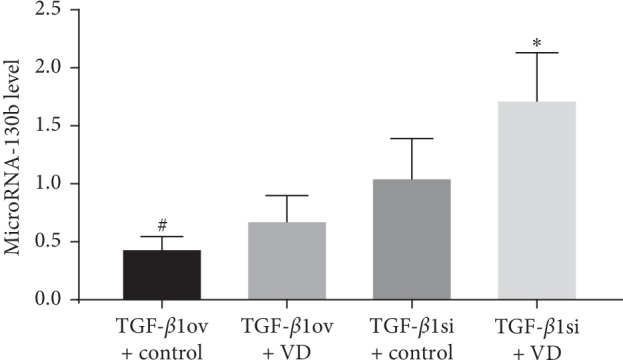
MiR-130b expression levels in DN rats. TGF-β1ov + control, TGF-β1 overexpression + oil; TGF-β1 ov + VD, TGF-β1 overexpression + 1,25(OH)2D3; TGF-β1si + control, TGF-β1 siRNA + oil; TGF-β1si + VD, TGF-β1 siRNA + 1,25(OH)2D3. ∗p < 0.05 vs TGF-β1si + control; #p < 0.05 vs TGF-β1ov + VD.